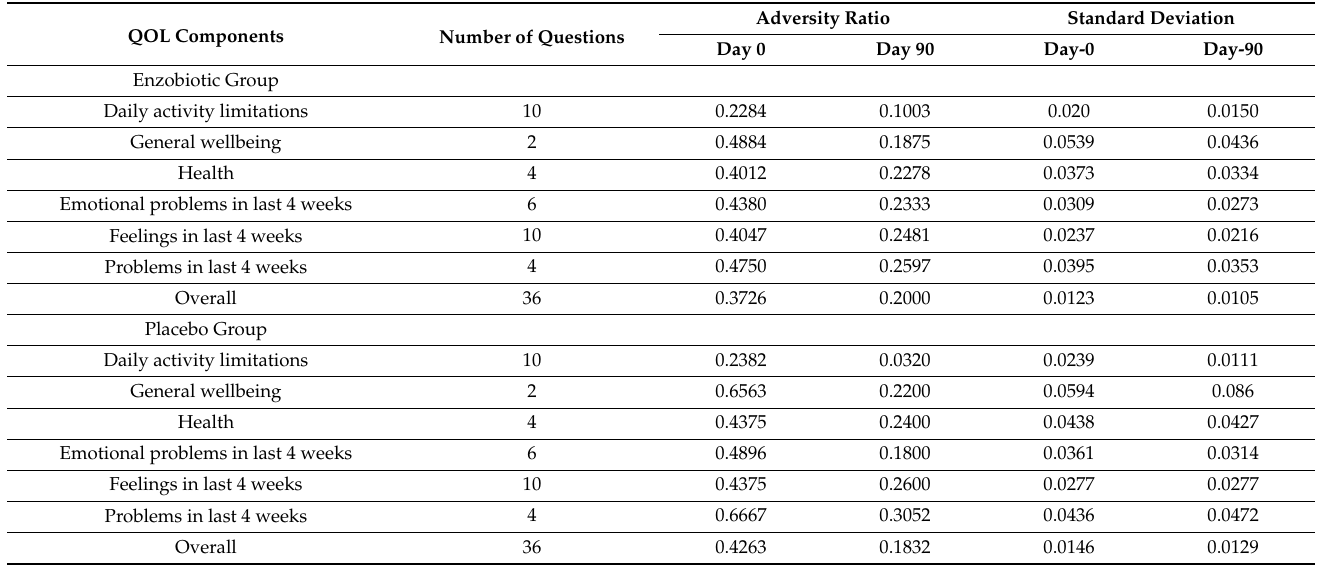
Table 5. Proportion of subjects with relatively bad quality of life scores (adversity